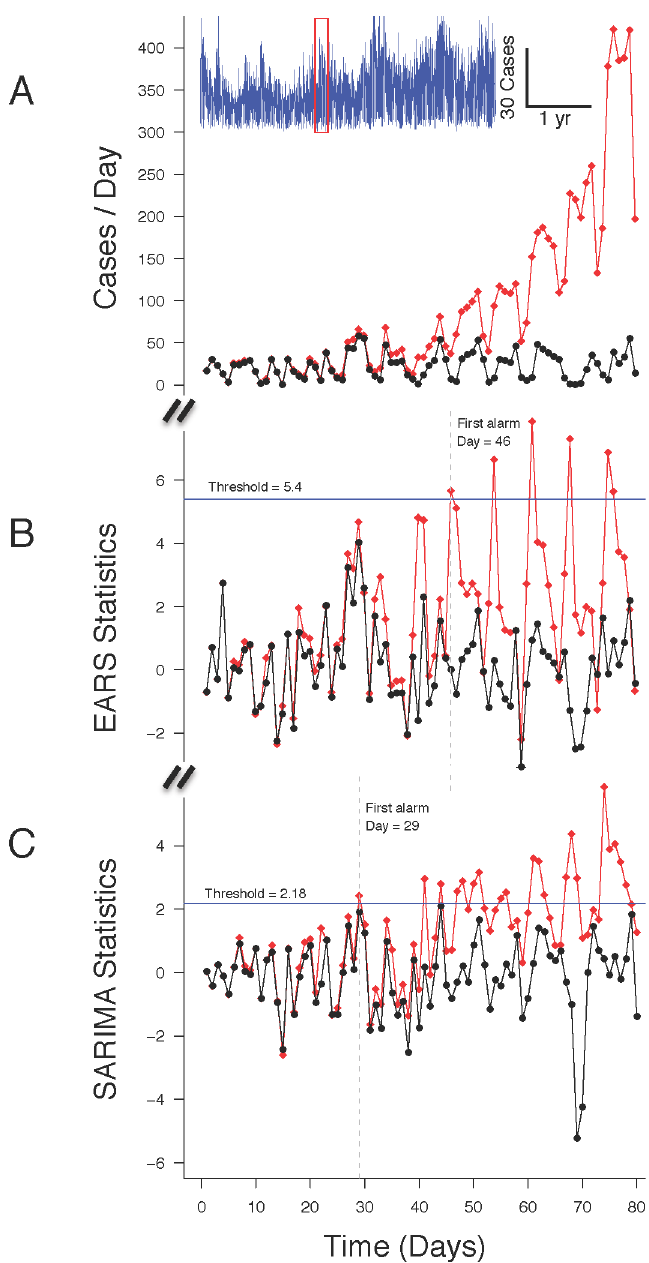
Fig 1. Comparing surveillance systems performance. Y-axis shows daily case counts (panel A) and corresponding EARS (panel B) and SARIMA statistics (panel C) as a function of time (x-axis) for an 80-day period extracted from a multiyear time series of authentic ARI cases (red rectangle region from the blue tracing insert in panel A). Black circles plot values due to background ARI cases only; red diamonds plot values due to background + injected epidemic cases. Note that at equivalent thresholds, corresponding to a 1% FAR (horizontal blue lines in panels B and C), the first true positive alarm (vertical dashed lines in panels B and C) occurs earlier with SARIMA (day 29, panel C) than with EARS (day 46, panel